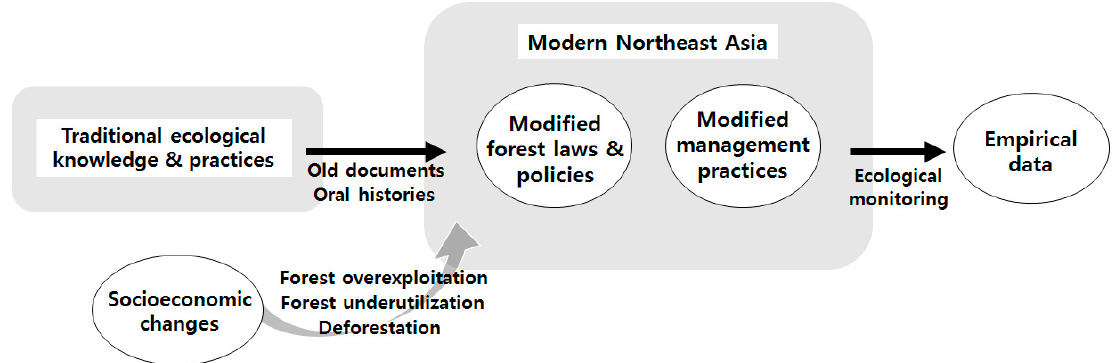
Figure 4. Role of traditional ecological knowledge within the forestry sector in modern Northeast Asia.